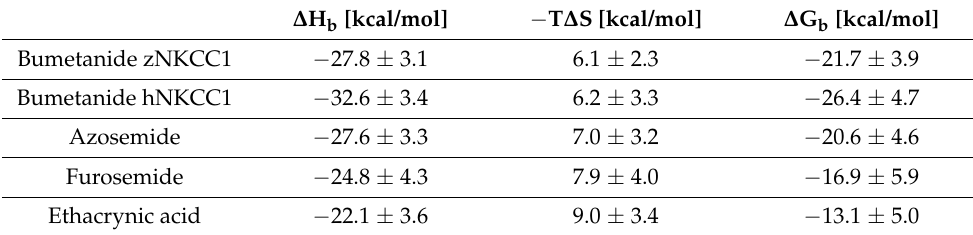
Table 1. Binding free energies ( ∆ G b , kcal/mol)) of different NKCC1 inhibitors as obtained by ( − T ∆ S) contribution to the ∆ G b are provided. Standard deviations of all values are reported.